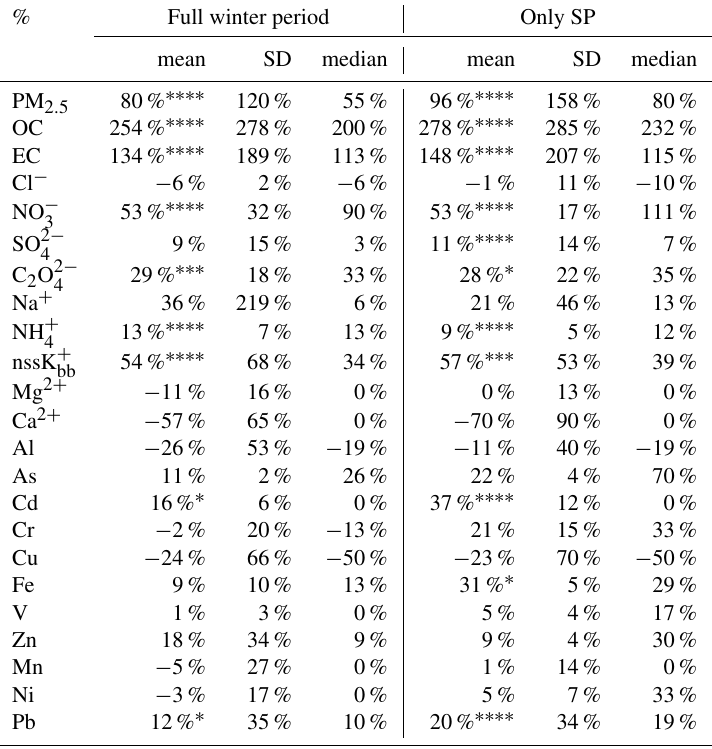
Table 2. The % increase in the diurnal distribution of all studied elements and species during the nighttime compared to the daytime in winter, shown for all winter samples ( n = 447) and smog pollution events (SP, n = 289). %